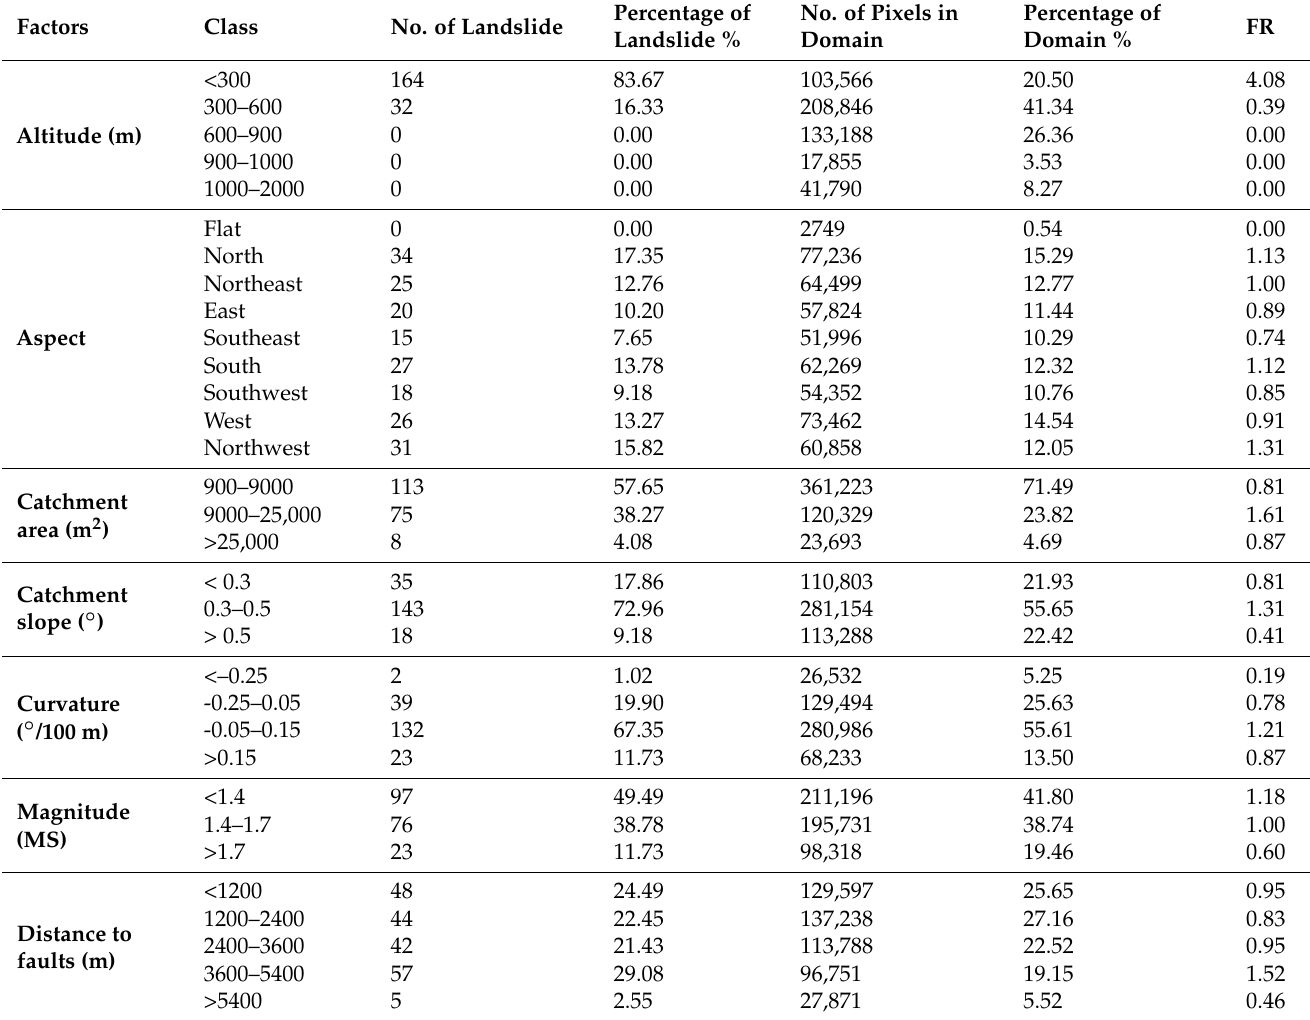
Table A1. Spatial relationship between each landslide conditioning factor and landslides using FR